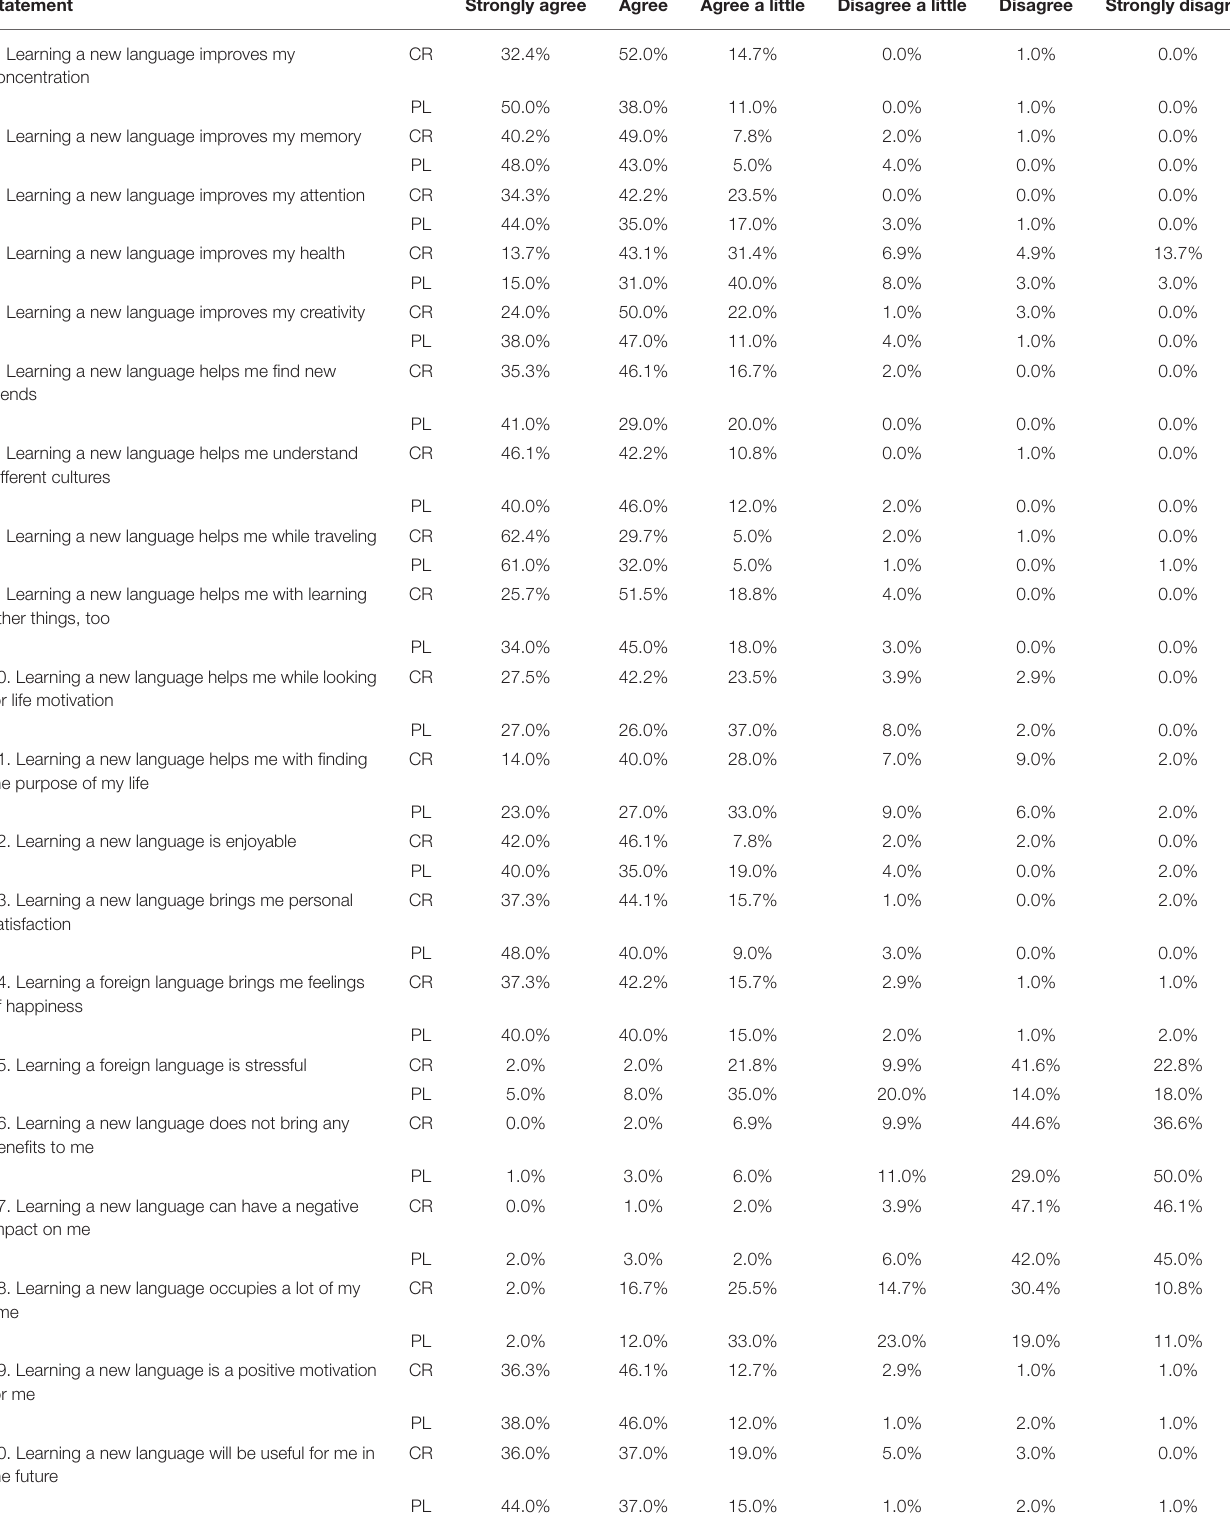
TABLE 3 | Results of the Czech experimental group and Polish second experimental